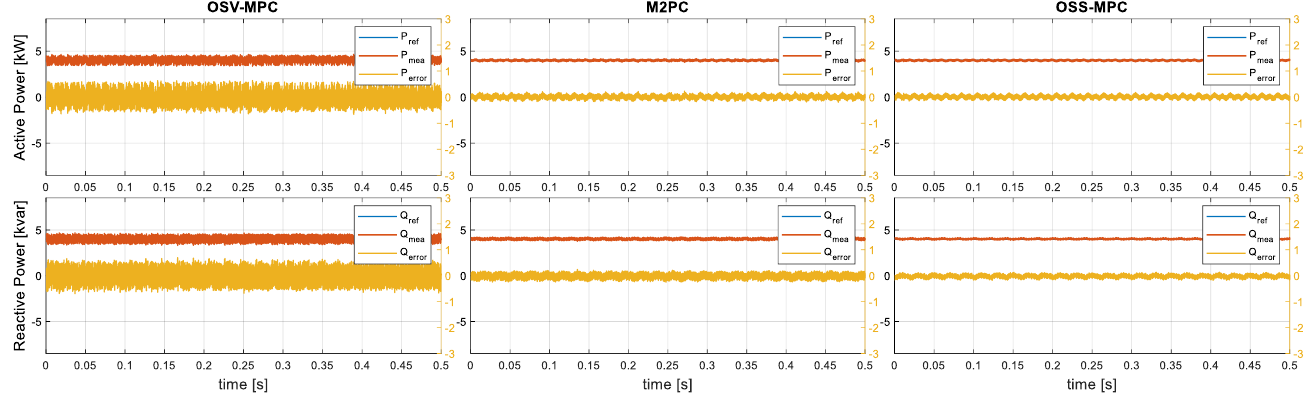
Figure 13. Output active and reactive power for each FCS-MPC technique for 𝑃 ∗ = 4 kW, 𝑄 ∗ = 4 kVAr. Table 4. Steady state experimental results.